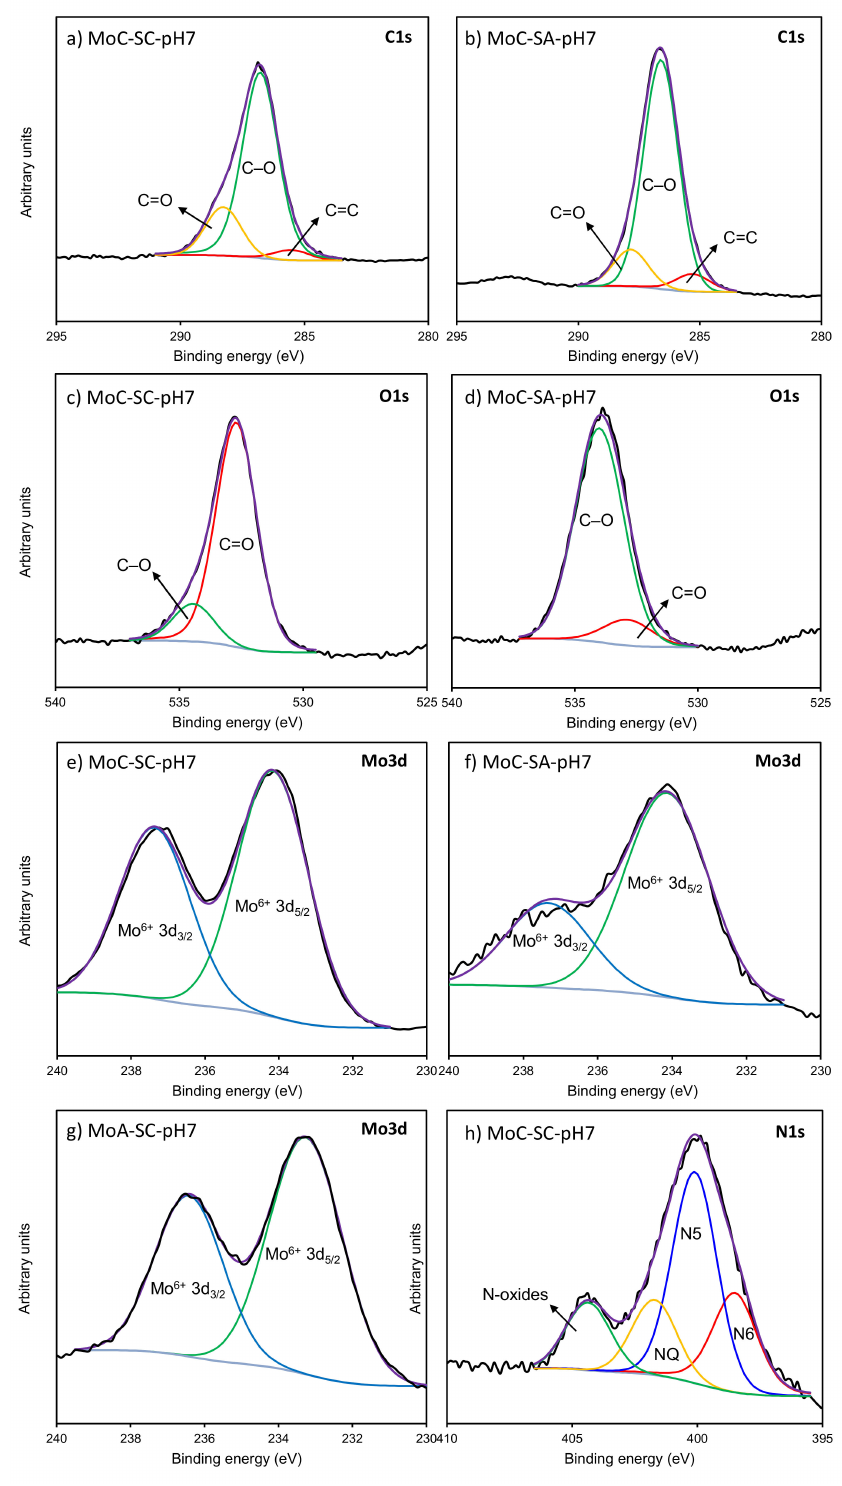
Figure 1. Analysis of the C1s ( a , b ), O1s ( c , d ), Mo3d ( e – g ) and N1s ( h ) high resolution XPS core-level spectra of Mo-doped organic